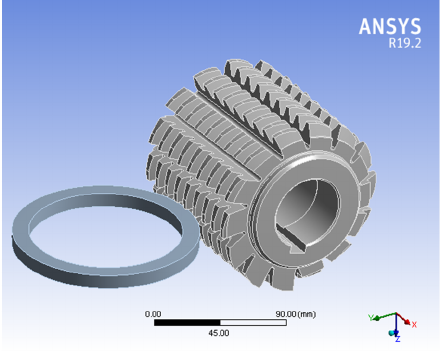
Figure 5. Geometric model for the assembly.